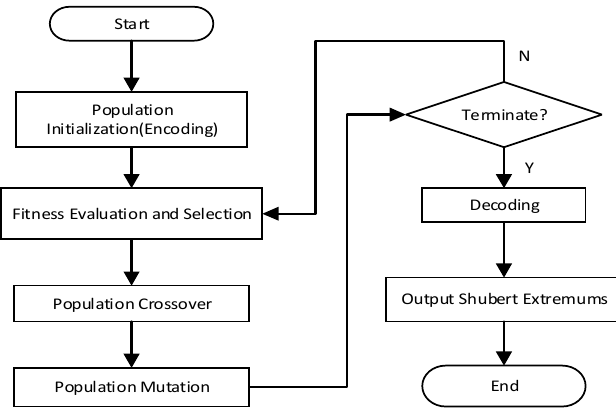
Figure 3. Single-node GA for solving ESMPF.